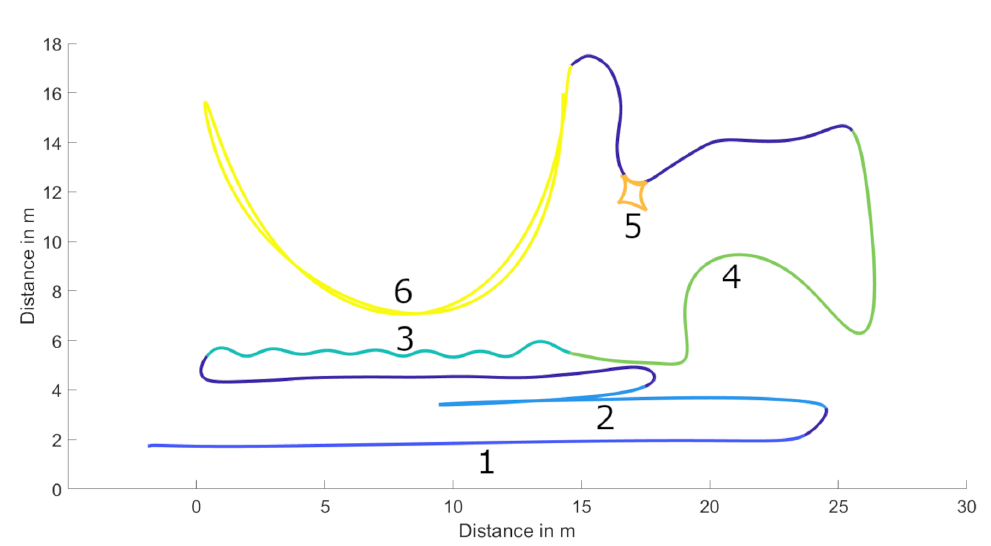
Figure 4. Sport-specific course (SSC) example with Qualisys data. Exercises in chronological order: 1 = linear sprint; 2 = 505 agility test; 3 = zig-zag jogging; 4 = squat jump and sharp changes of direction; 5 = multi-directional lunges; 6 = two curved sprints